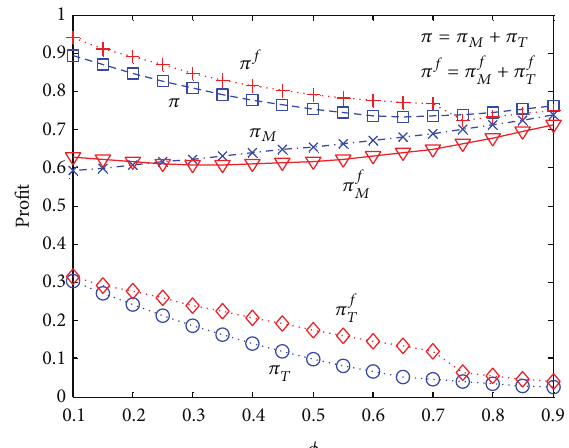
Figure 2: The effect of market share and channel fairness on